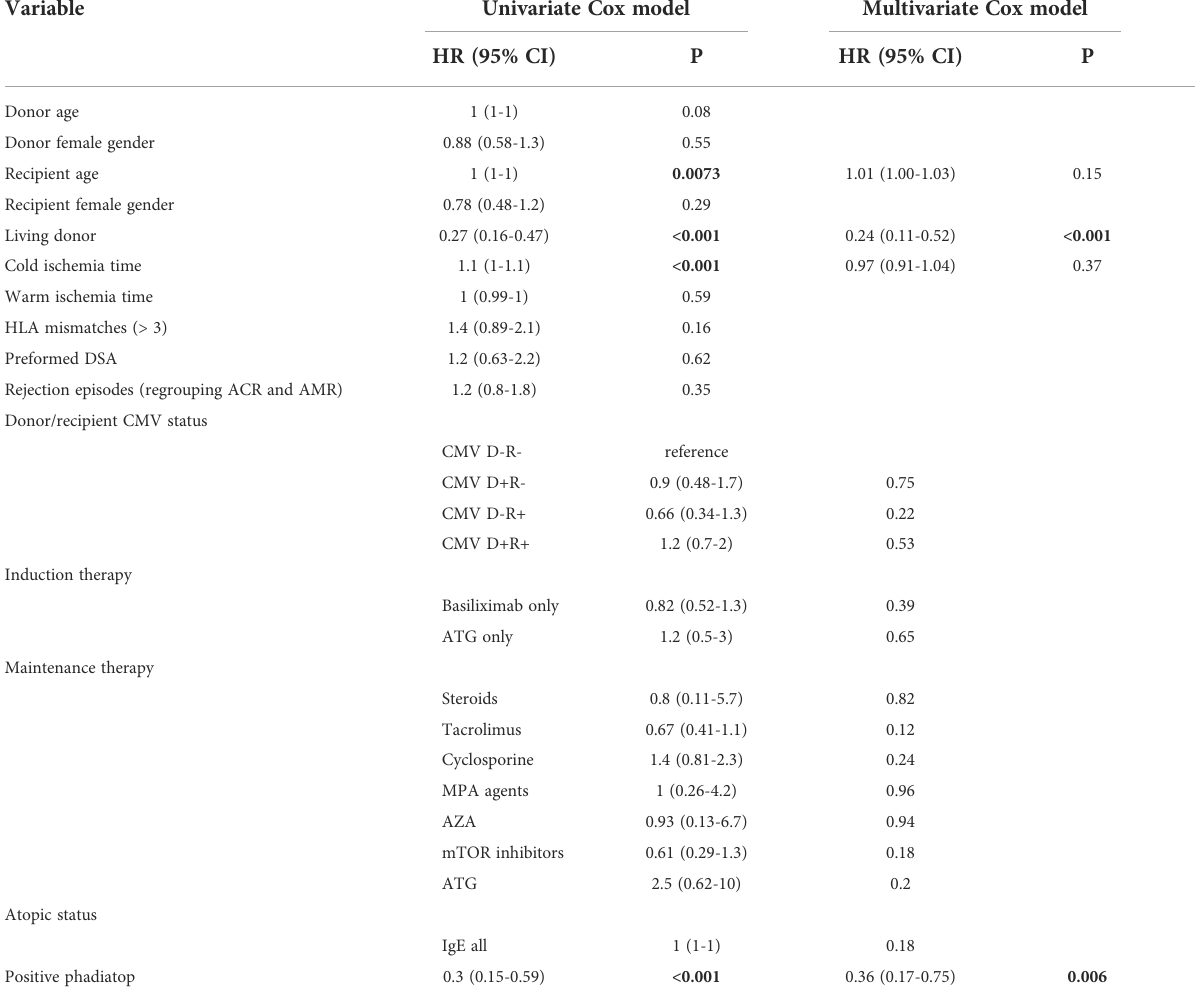
TABLE 3 Risk factors for graft loss during